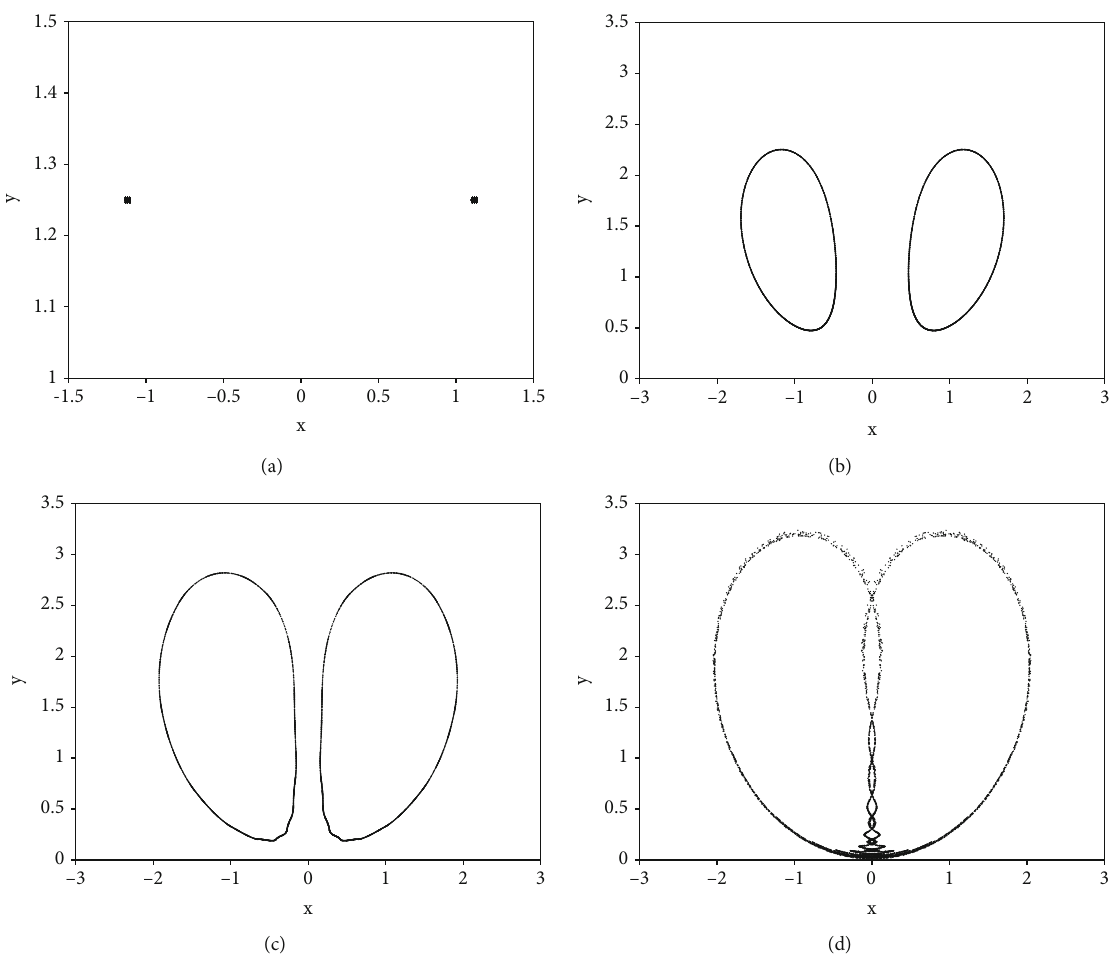
Figure 3: Phase diagrams of map (10) with di ff erent initial conditions ð x δ = 0 : 55 . (d) δ = 0 : 60